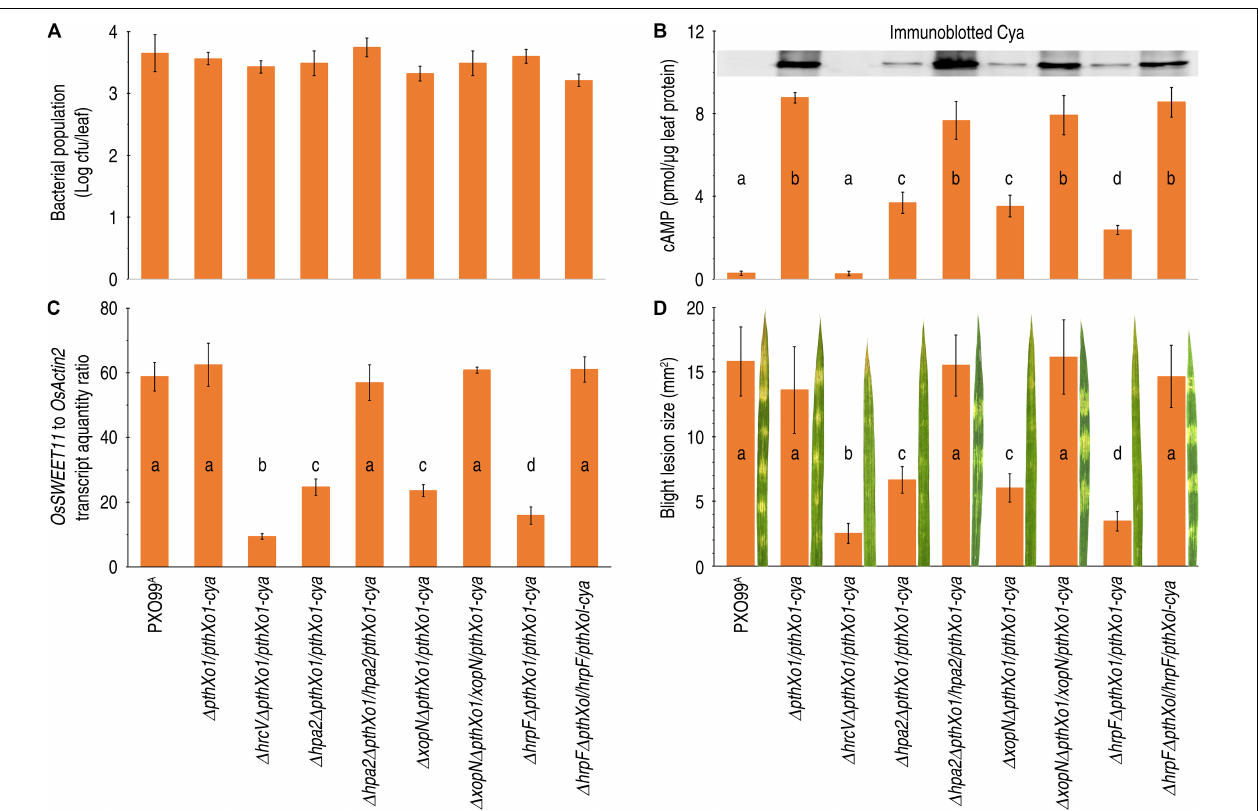
FIGURE 4 | The effects of hpa1 , hpa2 , and hrpF on PthXo1 translocation and bacterial virulence. (A–D) Leaves of 14-day-old Nipponbare rice seedlings were inoculated by infiltration with bacterial suspensions of PXO99 A and mutants defected in hpa1 , hpa2 , and hrpF , respectively. Inoculated leaves were excised and used in the different assays. Quantitative data are given as the means ± SDs. Different letters on bar graphs indicate significant differences of data obtained from the experiments performed on the different bacterial strains (ANOVA and Duncan’s test, P < 0.001, n = 3 independent experiment each involving 30 leaves of 15 plants). (A) Bacterial population in leaves 12 hpi. (B) PthXo1-Cya translocation levels shown as cytoplasmic cAMP concentrations in leaves 12 hpi. Inset shows immunoblotting of leaf proteins hybridized in the blot with specific anti-Cya antibody. (C) Rice OsSWEET11 gene expression in leaves 48 hpi. Gene expression was analyzed by RT-qPCR using the constitutively expressed OsActin2 gene as a reference. (D) Leaf blight severities and leaf images assessed at 7 dpi.